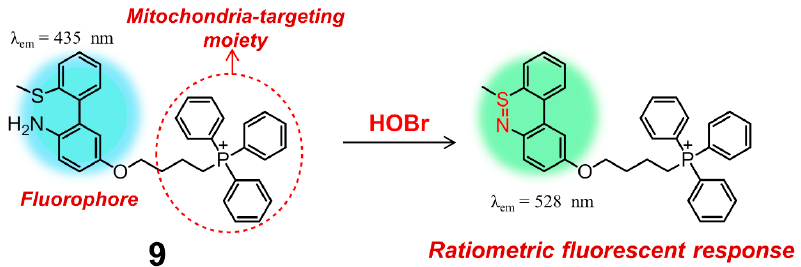
Figure 10. A ratiometric fluorescent probe 9 for bioimaging and biosensing of HOBr in mitochondria. The lysosome is the main digestive compartment in the eukaryotic cell, where nu- merous macromolecules are degraded for cellular recycling [94]. Lysosome-targeting fluorescent probes have also been widely constructed for various biological species [95–97]. In particular, lysosome contains hydrolytic enzymes with a high proton concentra- tion (pH < 6.0), meaning that it performs its function only under acidic conditions. Structurally, lysosome-localized fluorescent probes always incorporate lipophilic amines (e.g., morpholine and tertiary amine) [98]. These moieties can be easily protonated, which facilitate the positively charged probes to be entrapped and diffuse in the lysosomes.